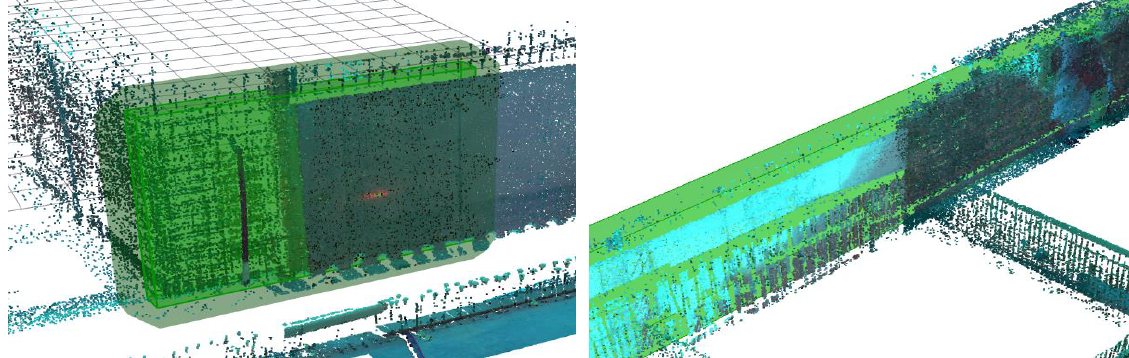
Figure 4d: Modeling abstractions such as grout volumes that were modeled as in-situ cast concrete walls do not correspond to predefined states.